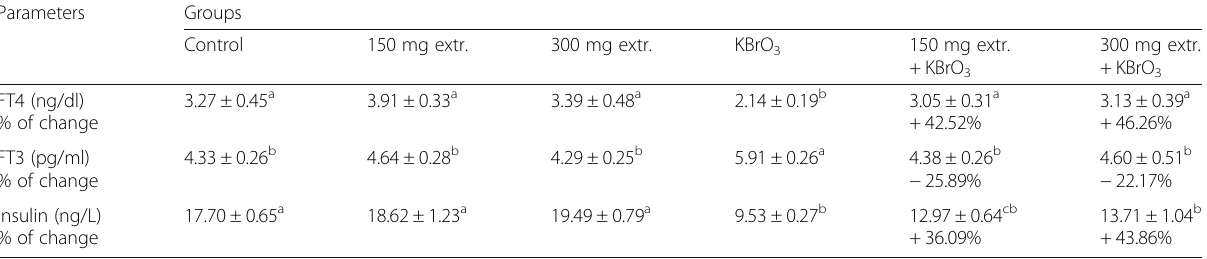
Table 3 Effect of potassium bromate and/or strawberry leaves extract on serum free thyroxin (FT4), free triiodothyronine (FT3) and insulin levels of different rat